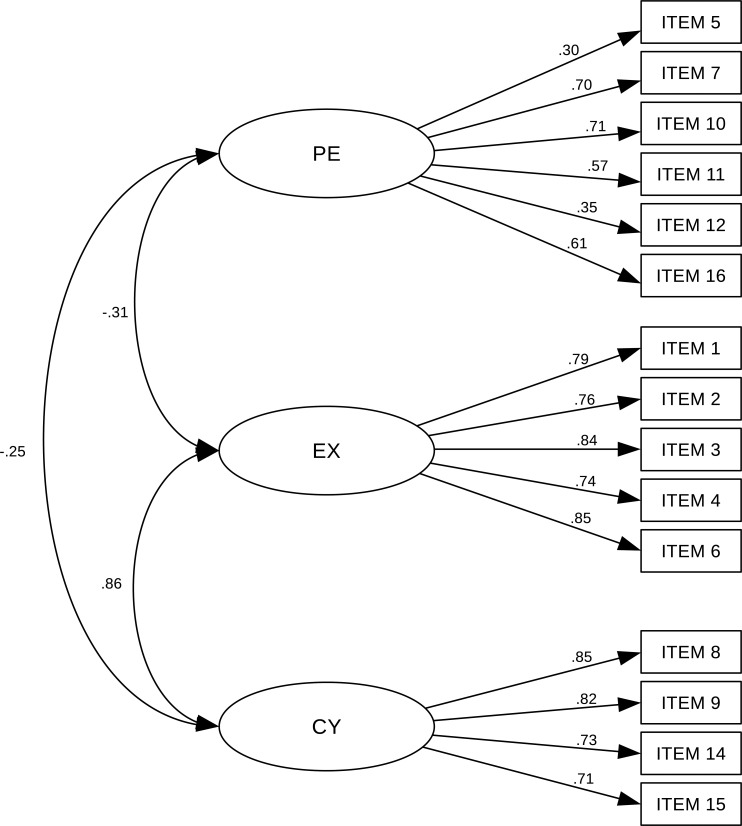
Standardized factor loadings for MBI-GS questionnaire in Serbian language.